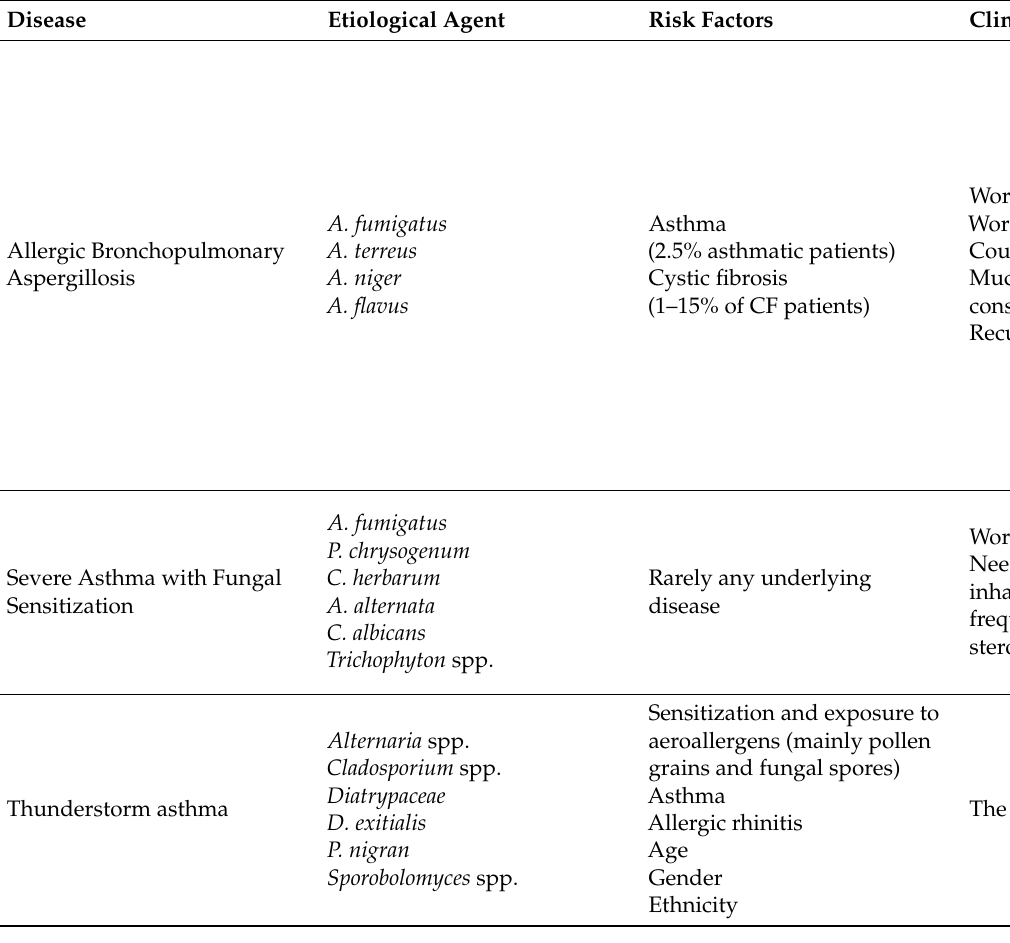
Table 1. Overview of the most common allergic fungal